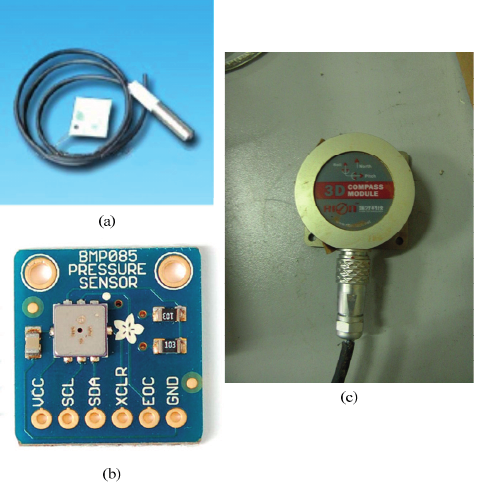
Figure 5. ( a ) Non-IEEE1451-based Barometer in Baoxie Sensor Web Experimental Field; ( b ) IEEE1451-based barometer at Yemaomian Landslide Monitoring Station; ( c ) IEEE1451-based three-dimensional electronic compass at Yemaomian Landslide Monitoring